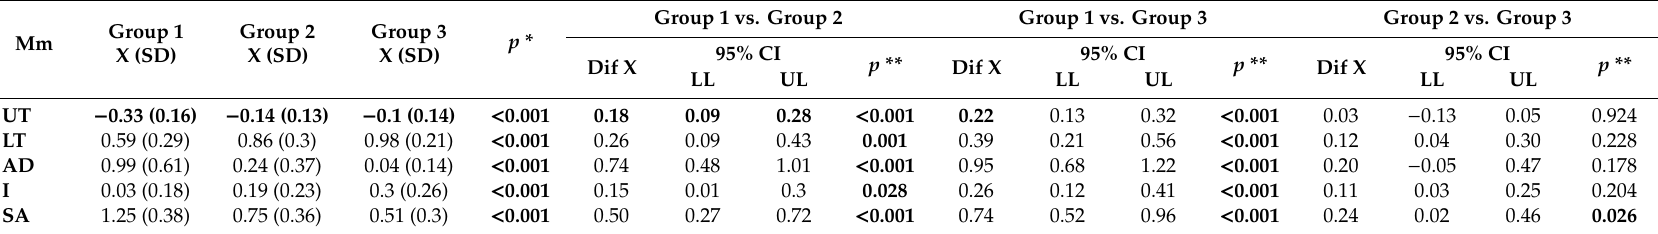
Table 3. Onset of muscle activity. Flexion